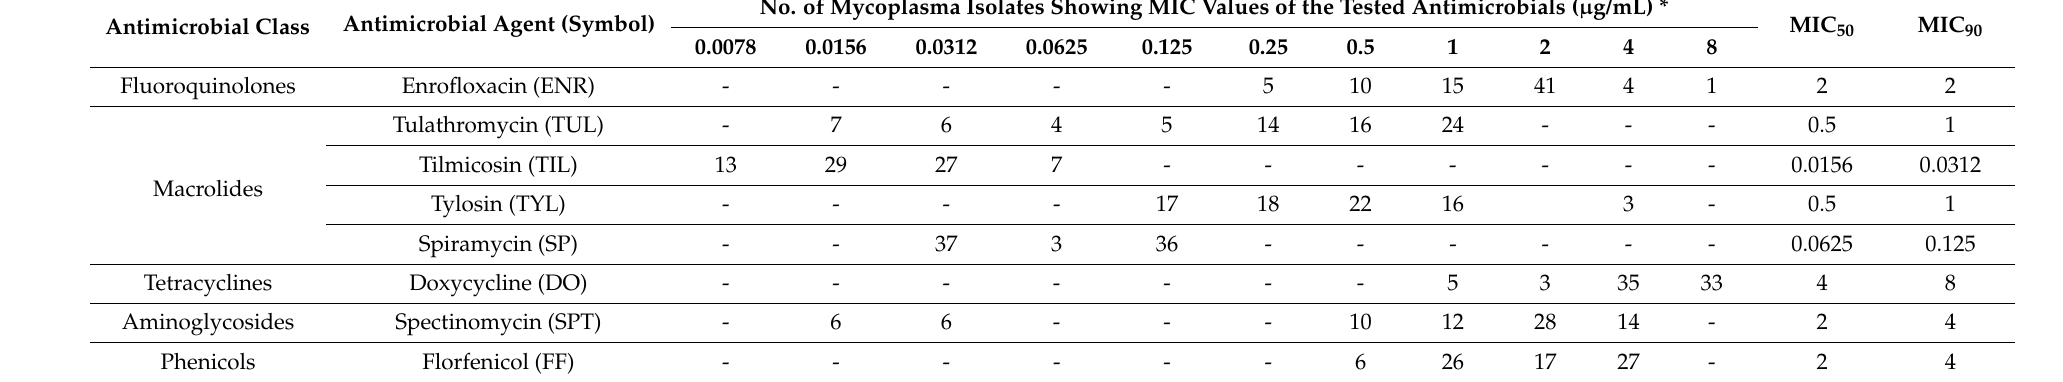
Table 5. Minimal inhibitory concentrations of the tested antimicrobials against mycoplasma isolates. Antimicrobial Class